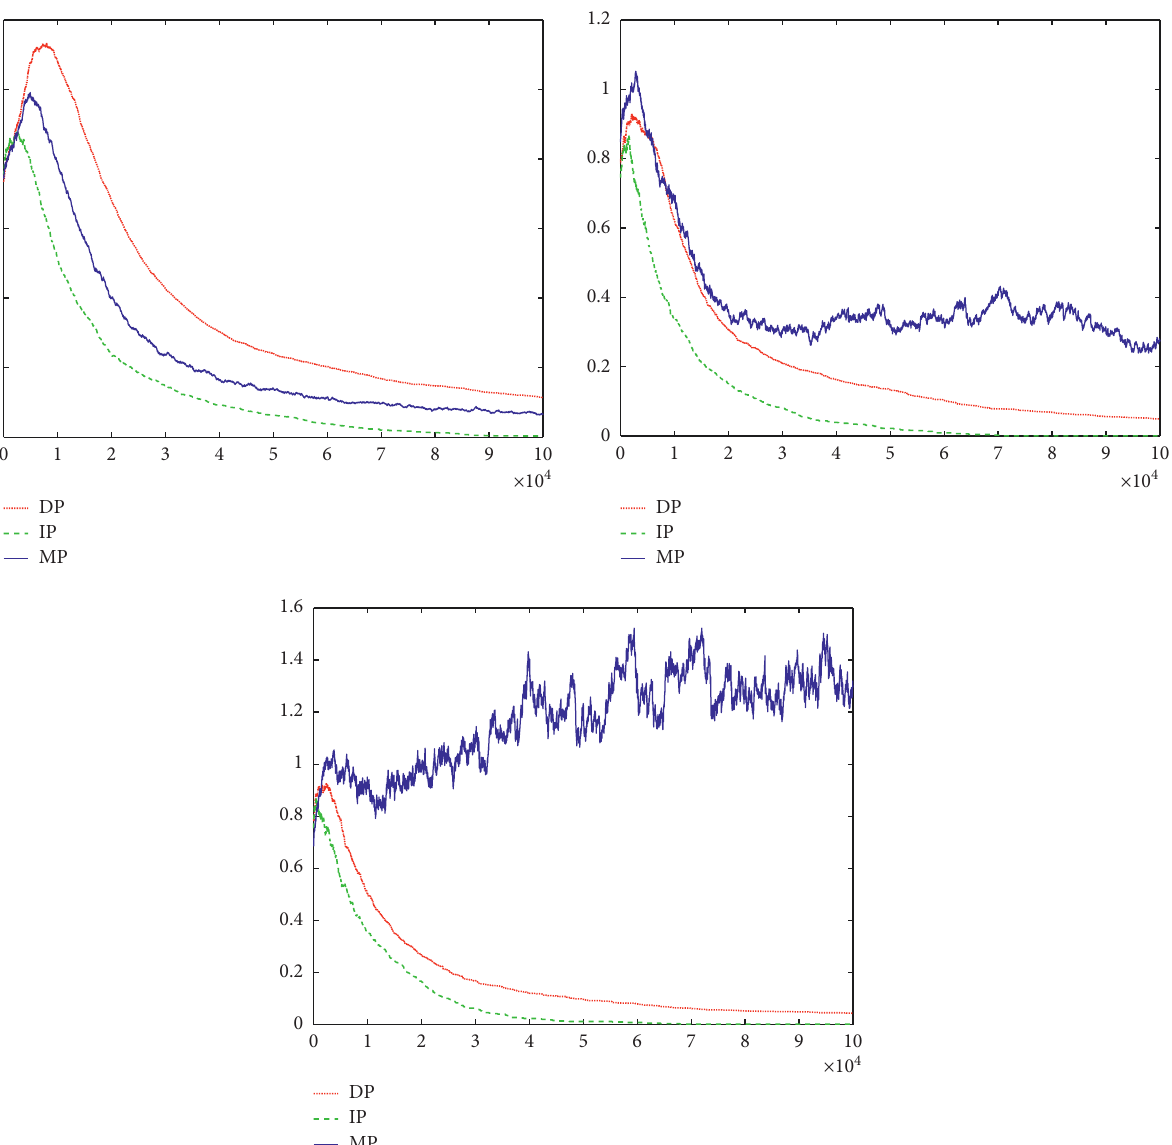
Figure 11: Knowledge equilibrium in a small-world network when L � 2, 6, and